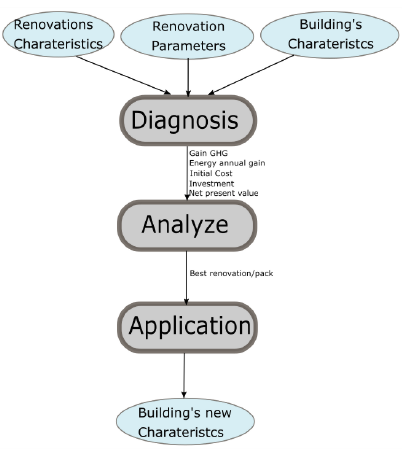
Figure 6. Features step of our renovation